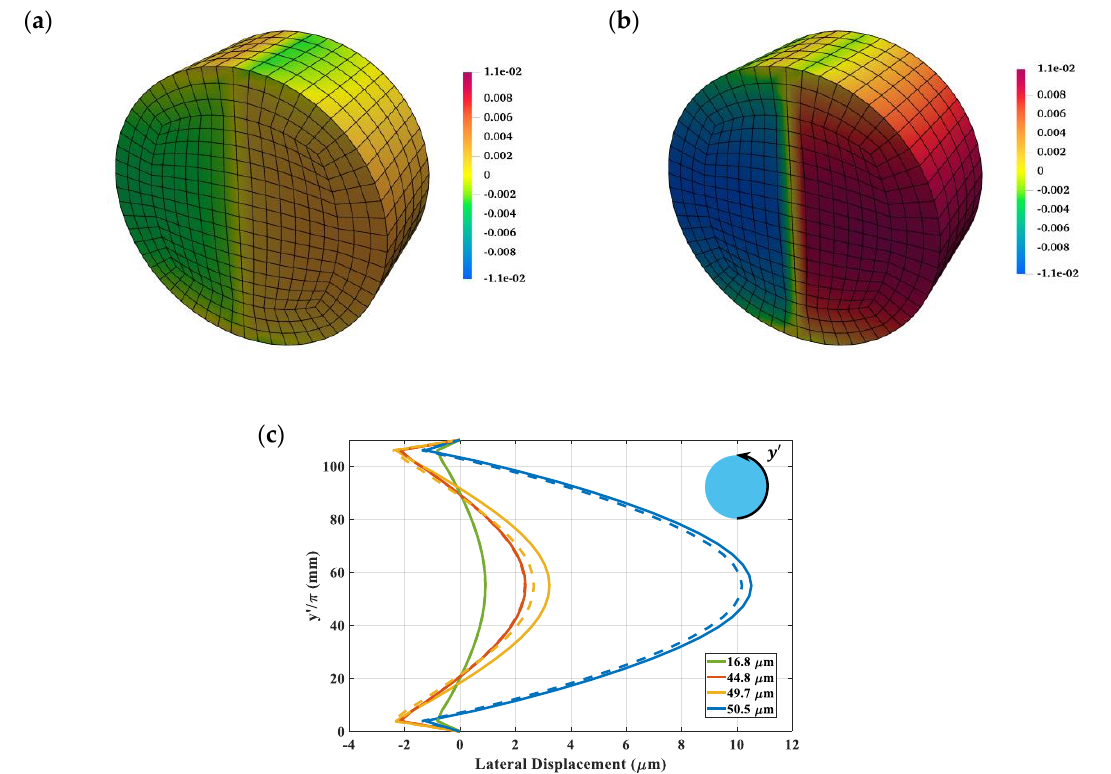
Figure 3. Lateral displacement field ( mm ) at ( a ) the vertical displacement of 49.7 μm (ultimate load) and ( b ) the vertical displacement of 50.5 μm (final state), ( c ) lateral displacement profiles along the circumferential boundary (solid line: front face; dash line: rear face).